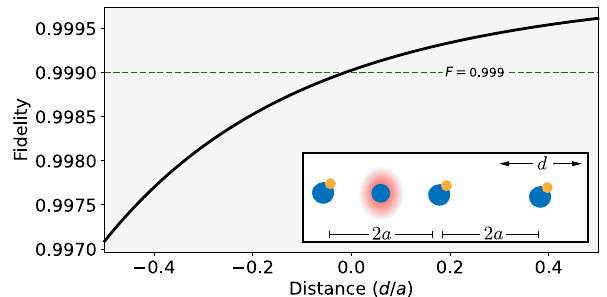
FIG. 6. In extending to larger arrays, neighboring molecules will affect the gate due to a suppressed dipolar interaction. In a uniform array, fidelities of just above 0.999 can be